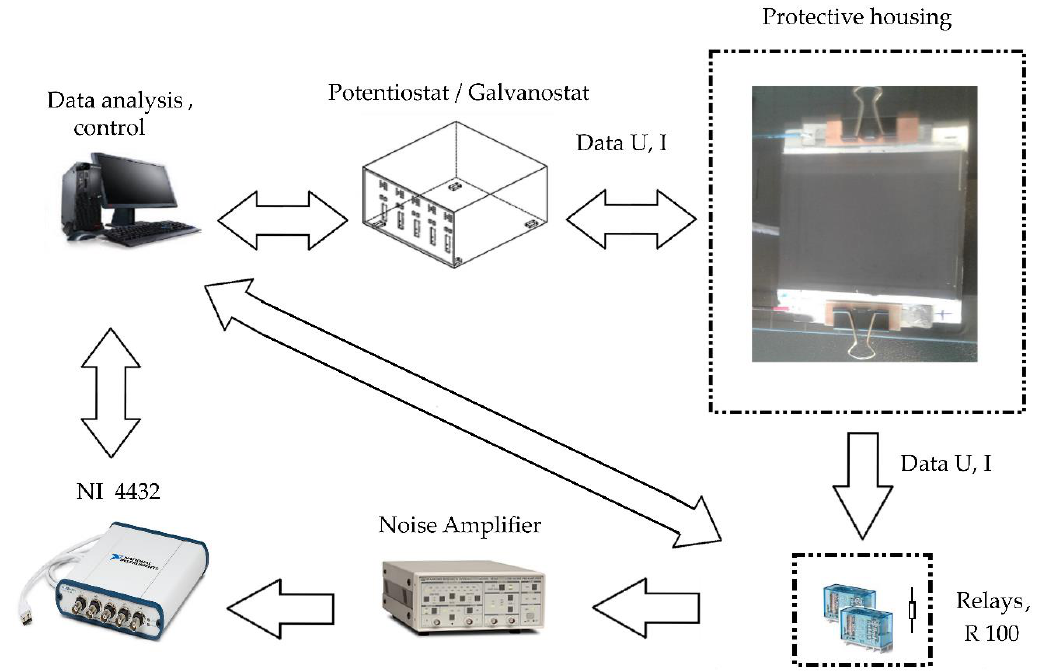
Figure 3. Block diagram of the measurement set-up applied for voltage noise time series recording.